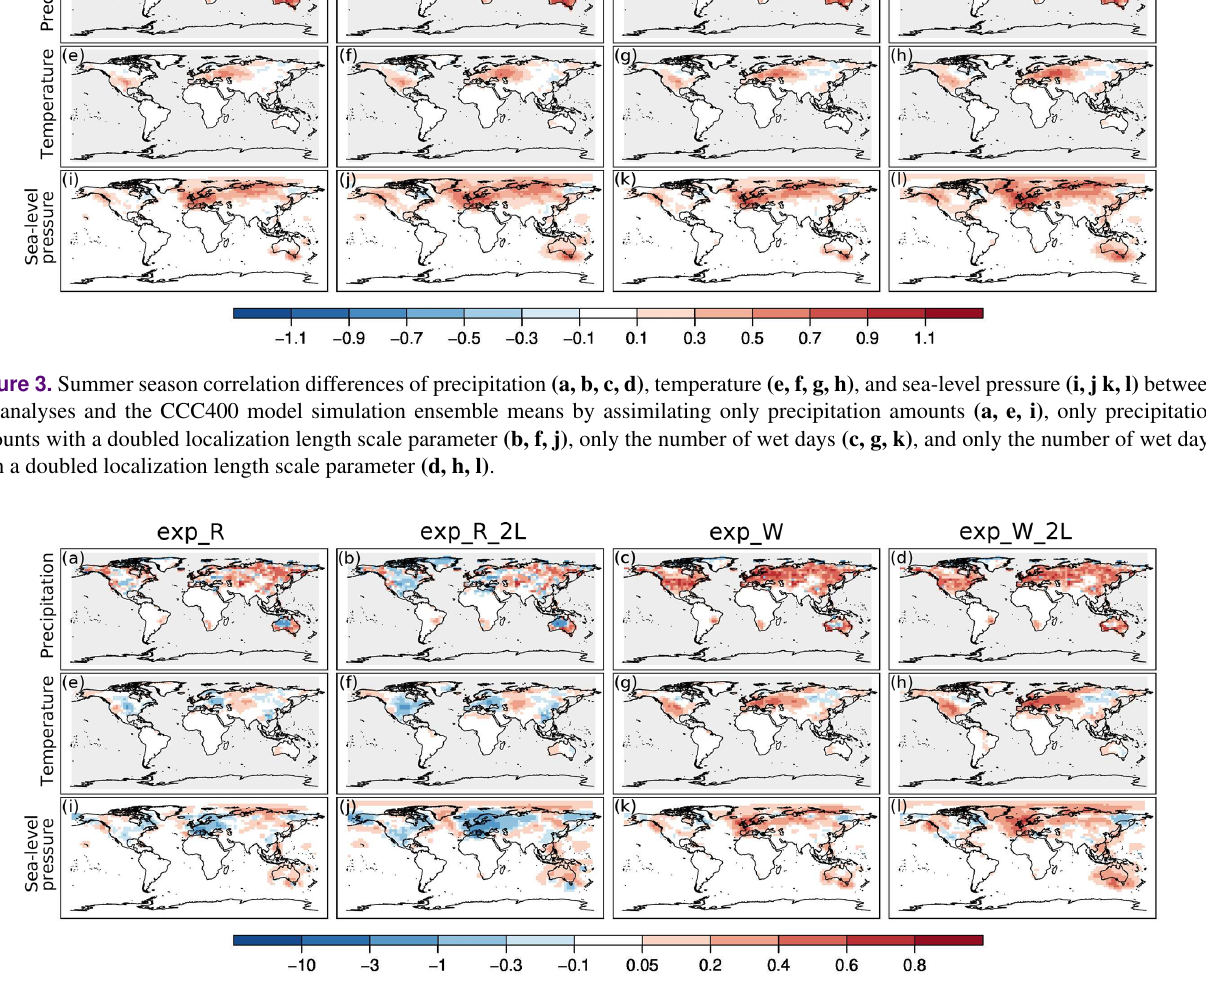
Figure 4. Summer season RMSESS values of precipitation (a, b, c, d) , temperature (e, f, g, h) , and sea-level pressure (i, j k, l) by assimilating only precipitation amounts (a, e, i) , only precipitation amounts with a doubled localization length scale parameter (b, f, j) , only the number of wet days (c, g, k) , and only the number of wet days with a doubled localization length scale parameter (d, h, l)